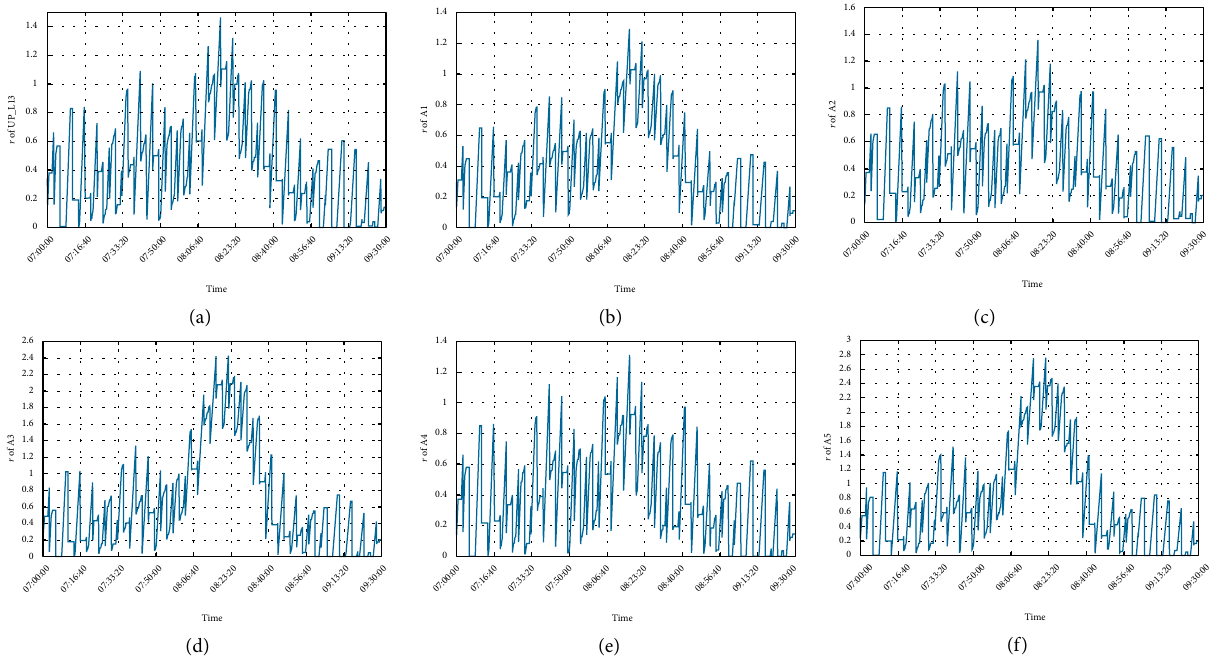
Figure 17: 𝑟 for UP_L13 and its subareas (a) UP_L13, (b) A1, (c) A2, (d) A3, (e) A4, and (f)